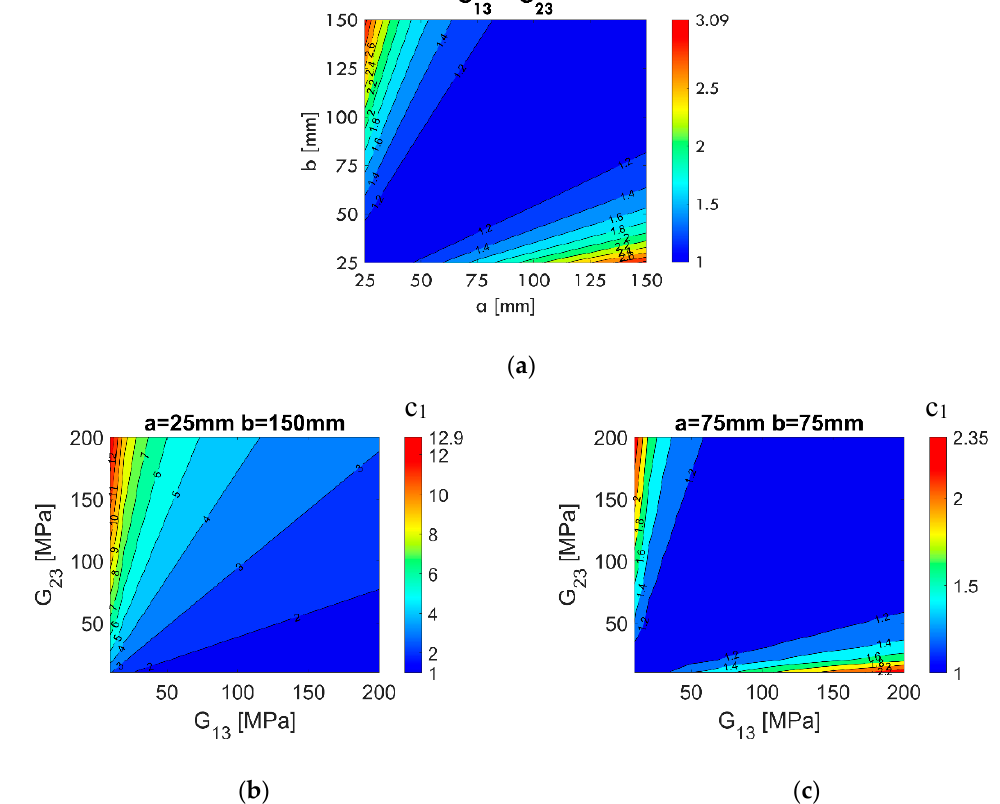
Figure 5. Influence of the relation a / b ( a ) and G 13 / G 23 for a sample of 25 × 150 mm ( b ), and a sample of 75 × 75 mm ( c ), on the value of the c 1 parameter.